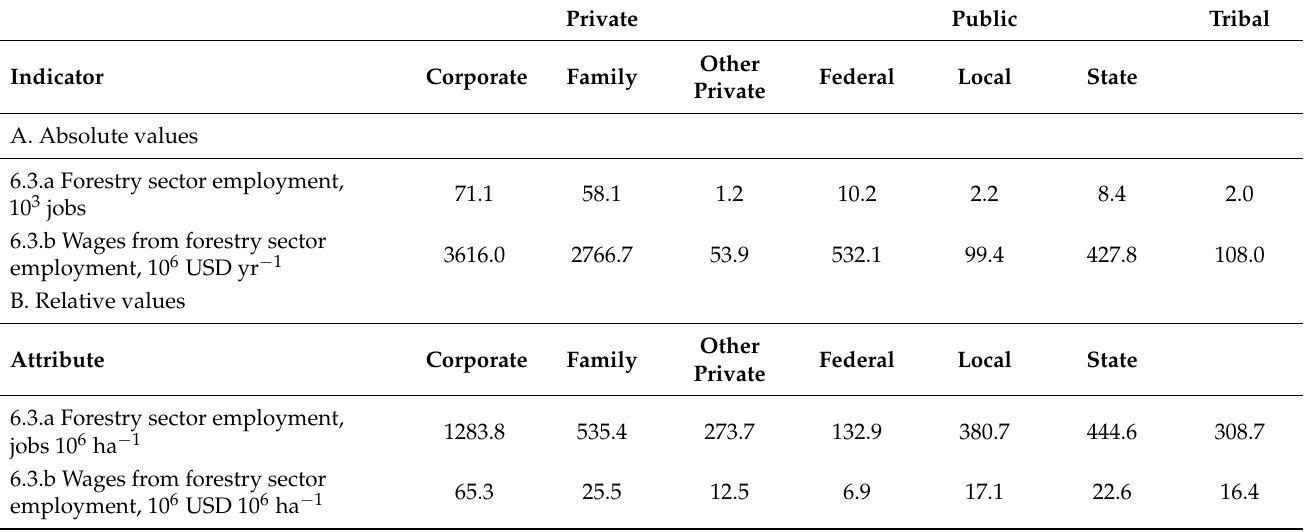
Table 7. Summary of selected Montr é al Process Criterion 6 Indicators by ownership category, conterminous USA in terms of: (A) absolute values (2019) and (B) relative values (2019). Indicators, including data sources, are described in Table